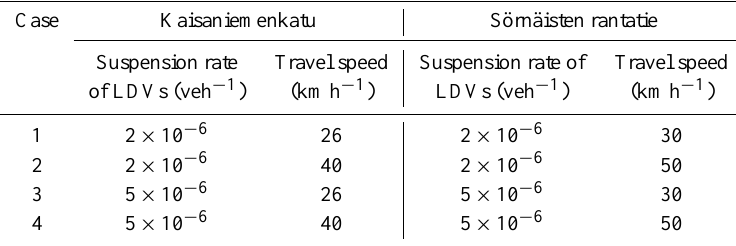
Table 3. The suspension rates of light-duty vehicles (LDVs) and the travel speeds selected for the sensitivity analyses of the NORTRIP model. Case